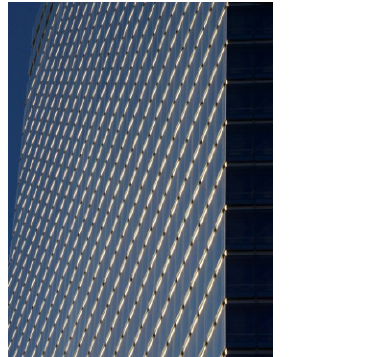
Figure 17a, b: view of the Linear Lap spandrels fully illuminated by daylight and view of the acute edge from the east as the sun sets.